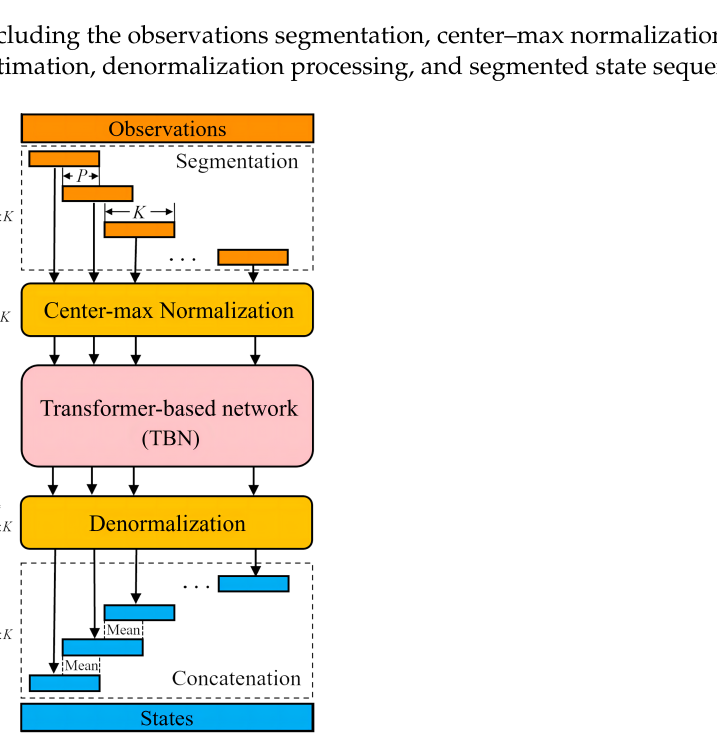
Figure 4. Structure of the transformer-based maneuvering target tracking. The observation sequences of targets are firstly segmented into subsequences z 1: K of length K with step size P . After that, z 1: K are converted to ˜ z ∗ by center–max normalization. Then, the TBN infers the normalized trajectory 1: K ˆ x ∗ from ˜ z ∗ . In addition, ˜ z ∗ are de-normalized to ˆ x 1: K . Finally, the overlapped region of ˆ x 1: K is 1: K 1: K 1: K averaged and concatenated to obtain the estimation of the complete state